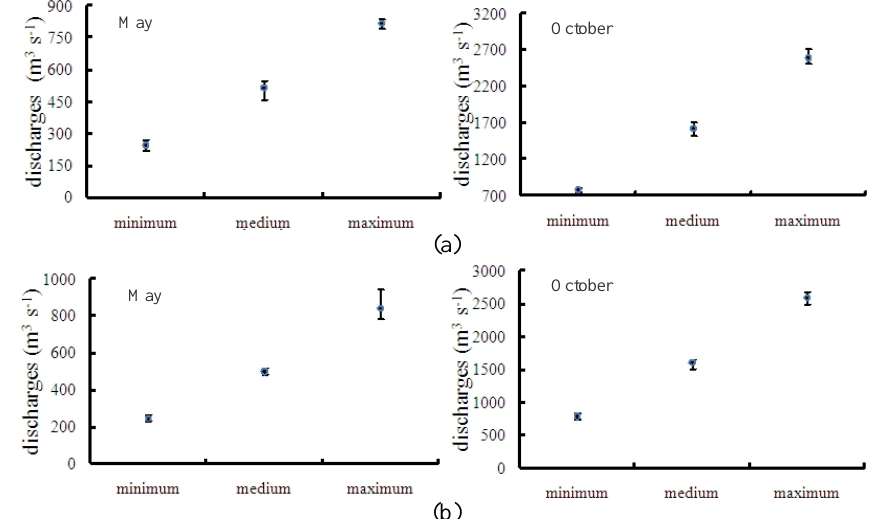
0.02.04.06.08.010.0 Fig. 4. Temporal variation in environmental flow and average natu- ral river discharge.